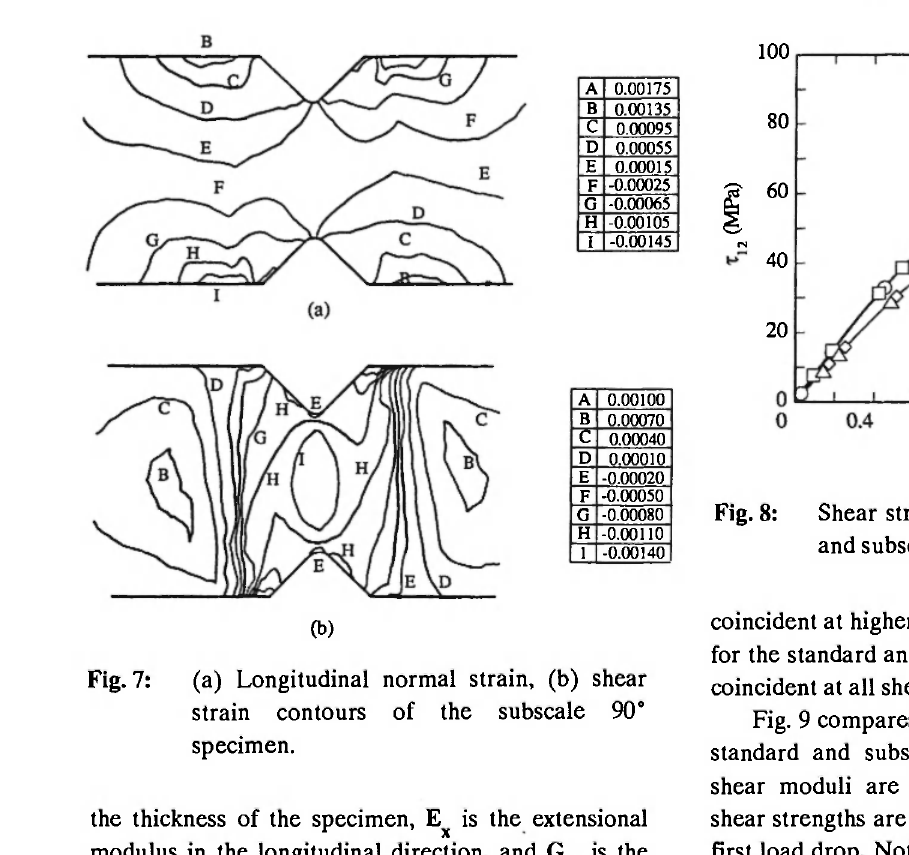
Fig. 8: Shear stress-strain data for typical standard and subscale 0° and 90°